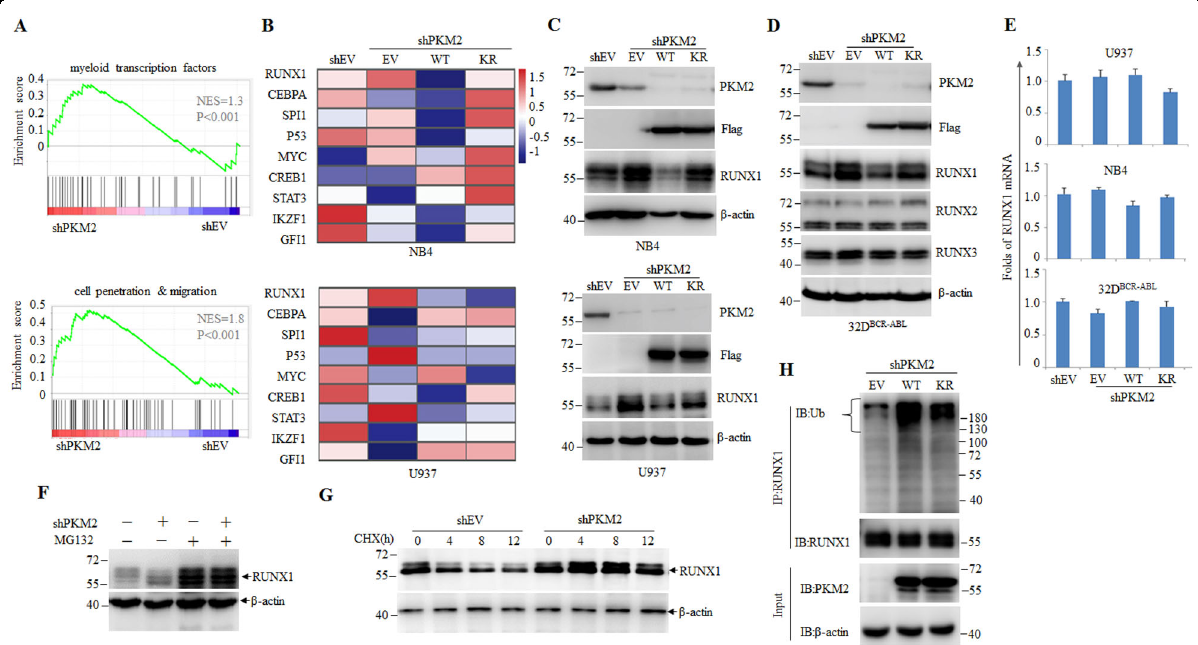
Fig. 5 PKM2 controls RUNX1 stability. A Gene set enrichment analysis (GSEA) of proteins the in PKM2-depleted U937 and NB4 cells measured by MS. B Heatmaps of levels of the indicated transcription factors in NB4 or U937 cells in which endogenous PKM2 was stably knocked out and WT PKM2 (WT) or K270R mutant (KR) were expressed. C , D NB4, U937, and 32D BCR-ABL rescue cell lines were subjected to western blots and the indicated proteins were detected. E The mRNA of RUNX1 was detected by quantitative real-time PCR in NB4, U937, and 32D BCR-ABL rescue cell lines. F Western blot analysis of RUNX1 in U937 cells transfected with shRNA targeting PKM2 and treated with MG132 (2 mM for 4 h) as indicated. G Western blot analysis of whole cell lysates derived from U937 cells stably expressing shRNA empty vector (EV) or shPKM2 and treated with cycloheximide (CHX, 20 mg/mL) for the indicated time points. β -actin was analyzed as an internal loading control. H U937 rescue cell lines were treated with MG132 (2 mM for 4 h) and IP assay were performed using antibody against RUNX1 followed by western blot